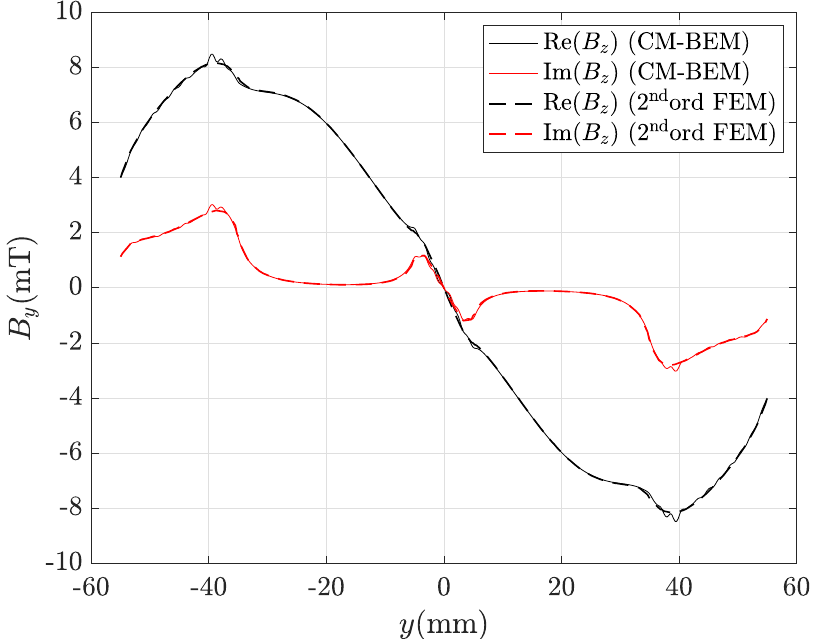
Figure 15. Real and imaginary parts of the y -axis magnetic flux density component at 200 Hz along the line A-B (CM–BEM plot is in straight line, FEM plot is in dashed